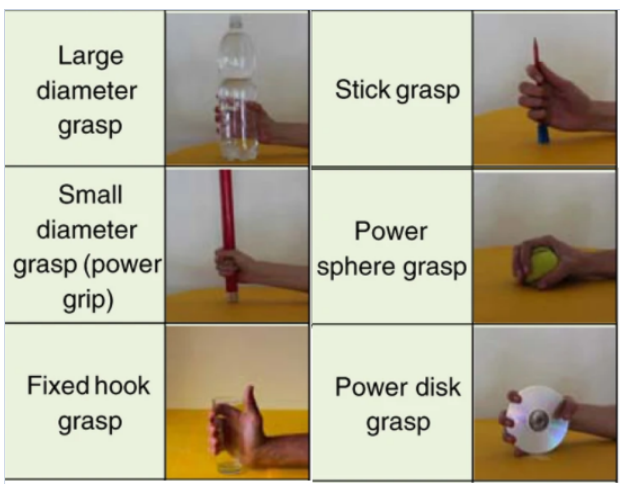
Figure 1. The 6 types of grasping movements we selected for experiments from Ninapro